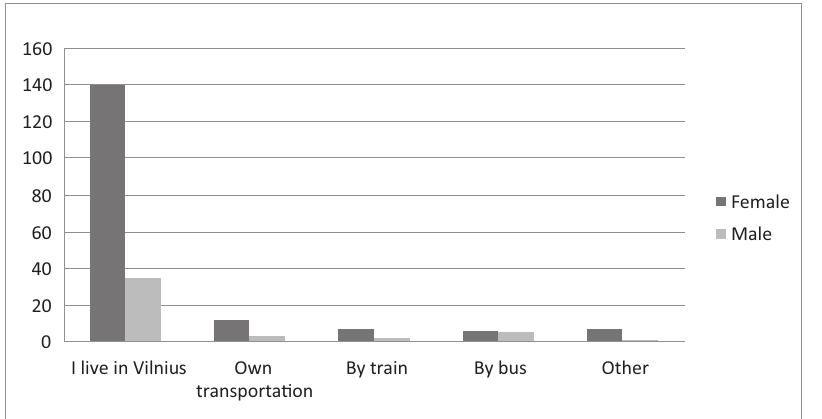
Fig. 14. Correlation between transportation type visitors have arrived to the festival and